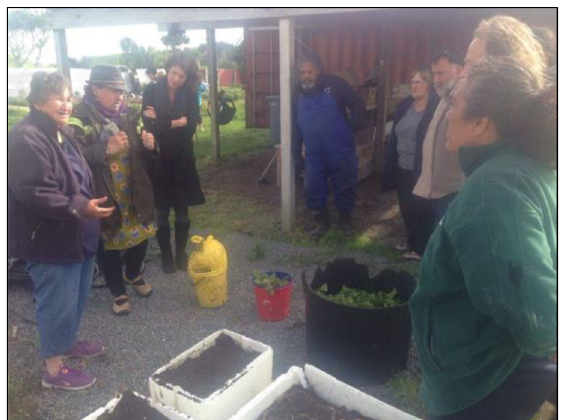
Figure 1. Hanui teaching about growing kumara t ī pu (kumara seedlings) during the exchange in